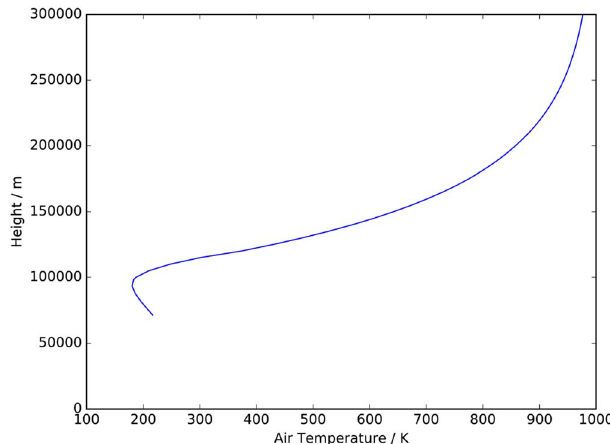
Fig. 8. Temperature pro fi le used for the relaxation of the temperature